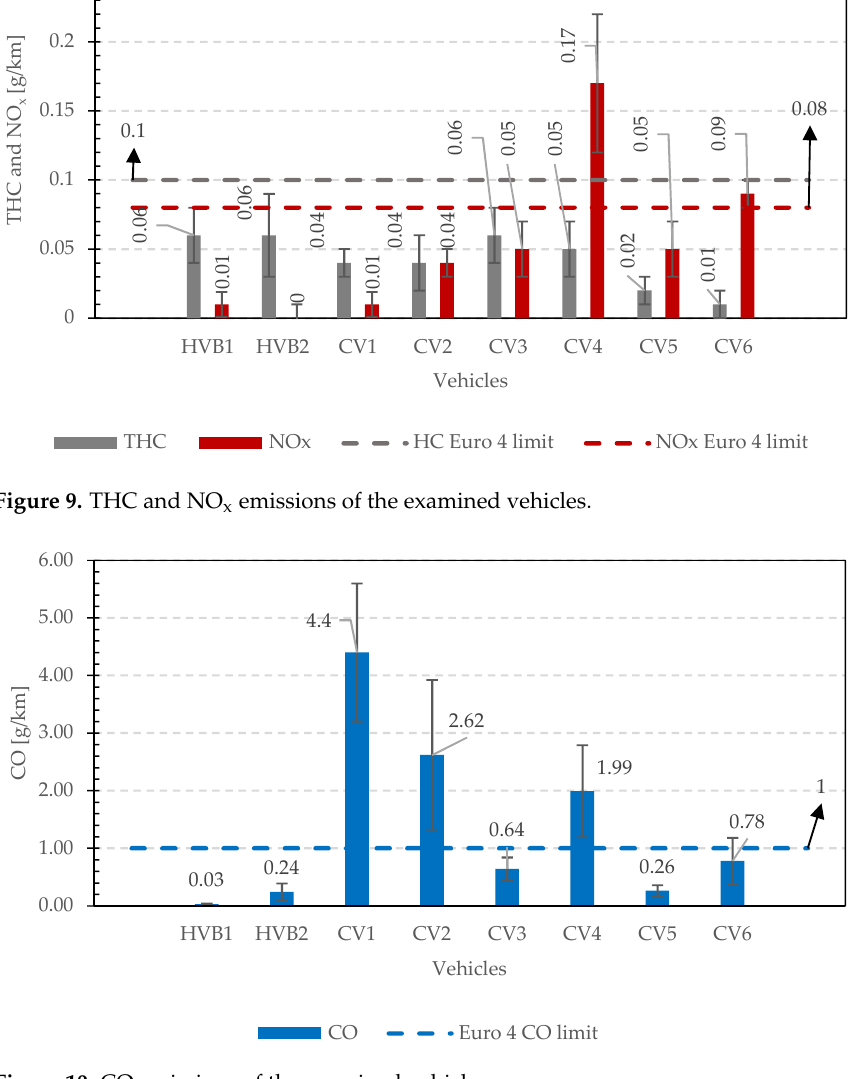
Figure 10. CO emissions of the examined vehicles.